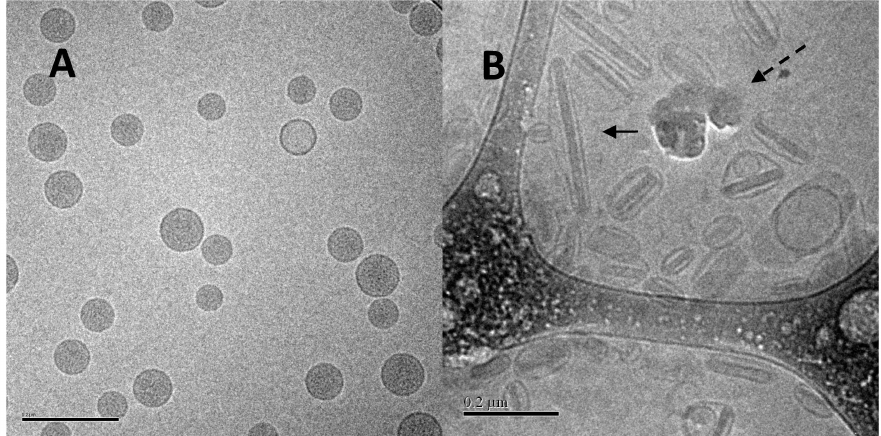
Figure 17. Cryo-TEM micrographs of 12.5 mg/mL Lipoquin, containing 90 mg/mL sucrose, pH 6.0. ( A ) Before freeze-thaw; ( B ) after freeze-thaw. The solid arrow in ( B ) shows a liposome containing a ciprofloxacin nanocrystal. The dashed arrow in ( B ) indicates ice artifacts introduced during sample preparation. Reprinted with permission from